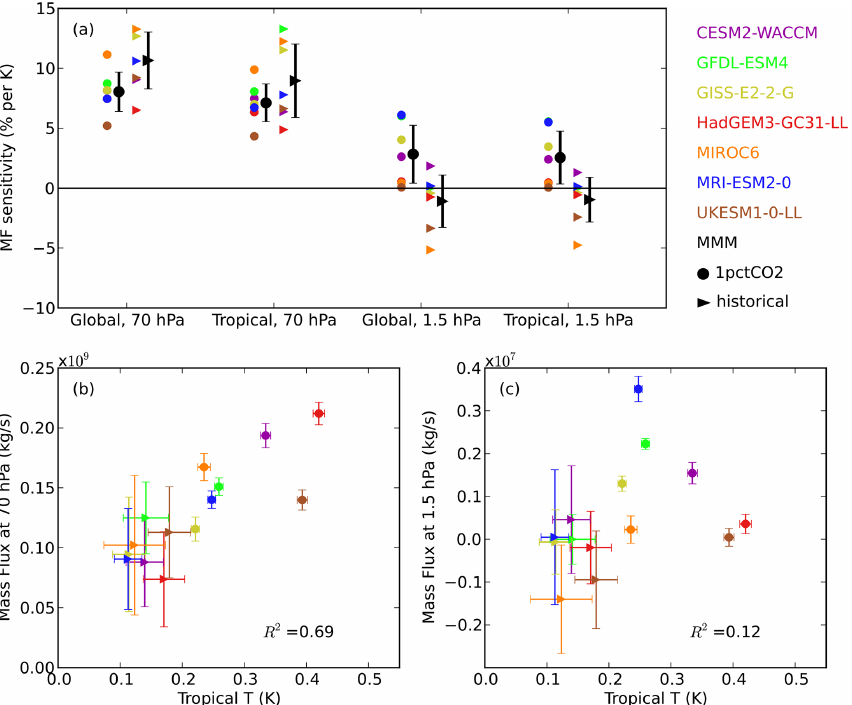
Figure 13. (a) Connections between long-term trends in mass flux in the shallow (70hPa) and deep (1.5hPa) branches and global and tropical mean surface temperature. The linear trends for the historical runs are calculated over the period 1960–2014 (triangles); for 1pctCO2 runs, trends are calculated over years 1–150 (circles). Black error bars show the MMM and 1 standard deviation among models. (b, c) Scatter plots of trends in mass flux at 70hPa (b) and 1.5hPa (c) versus tropical surface warming. The coefficient of determination R 2 across the models is shown in (b) and (c)